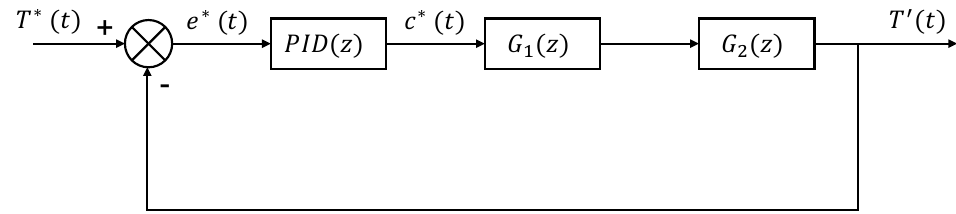
Figure 3. PID control system